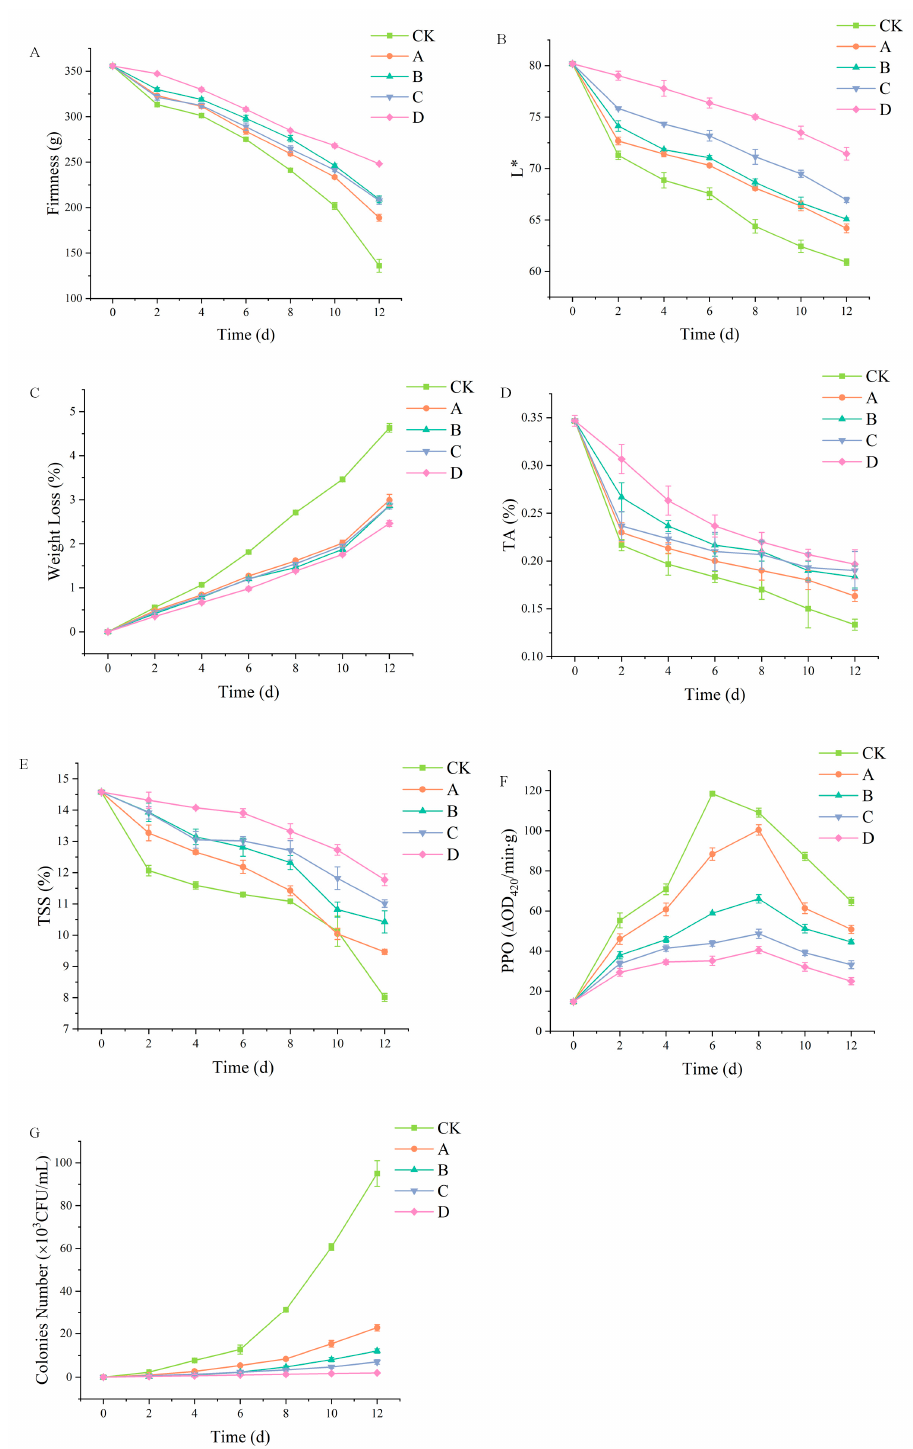
Figure 6. ( A ) Effect of coating treatment on firmness of fresh-cut apple; ( B ) Effect of coating treatment on chroma of fresh-cut apple; ( C ) Effect of coating treatment on weight loss rate of fresh-cut apple; ( D ) Effect of coating treatment on titratable acid of fresh-cut apple; ( E ) Effect of coating treatment on soluble solids of fresh-cut apple; ( F ) Effect of coating treatment on polyphenol oxidase activity of fresh-cut apple; ( G ) Effect of coating treatment on total colonies of fresh-cut apple (A: pure SA membrane; B: SA/CW composite membrane; C: SA/CW/G composite membrane; D: SA/CW/G/Vc-Ca composite membrane). (Original data shown in Table S1).